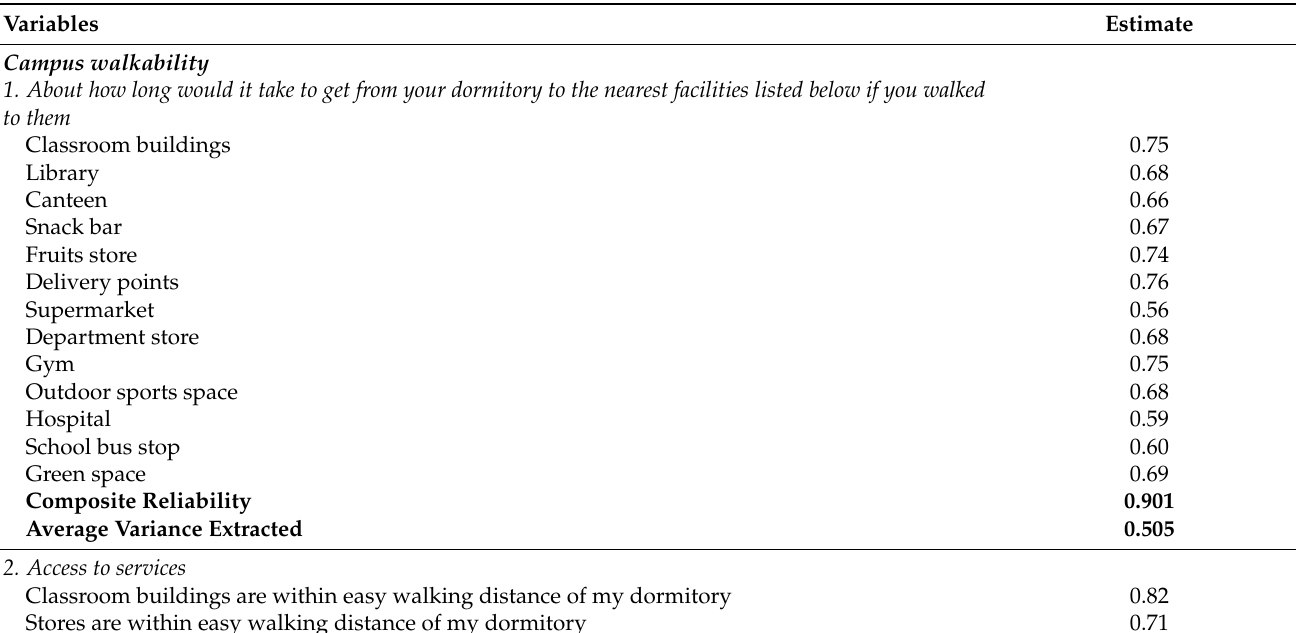
Table 2. Standardized Estimates for Measurement Items of Latent